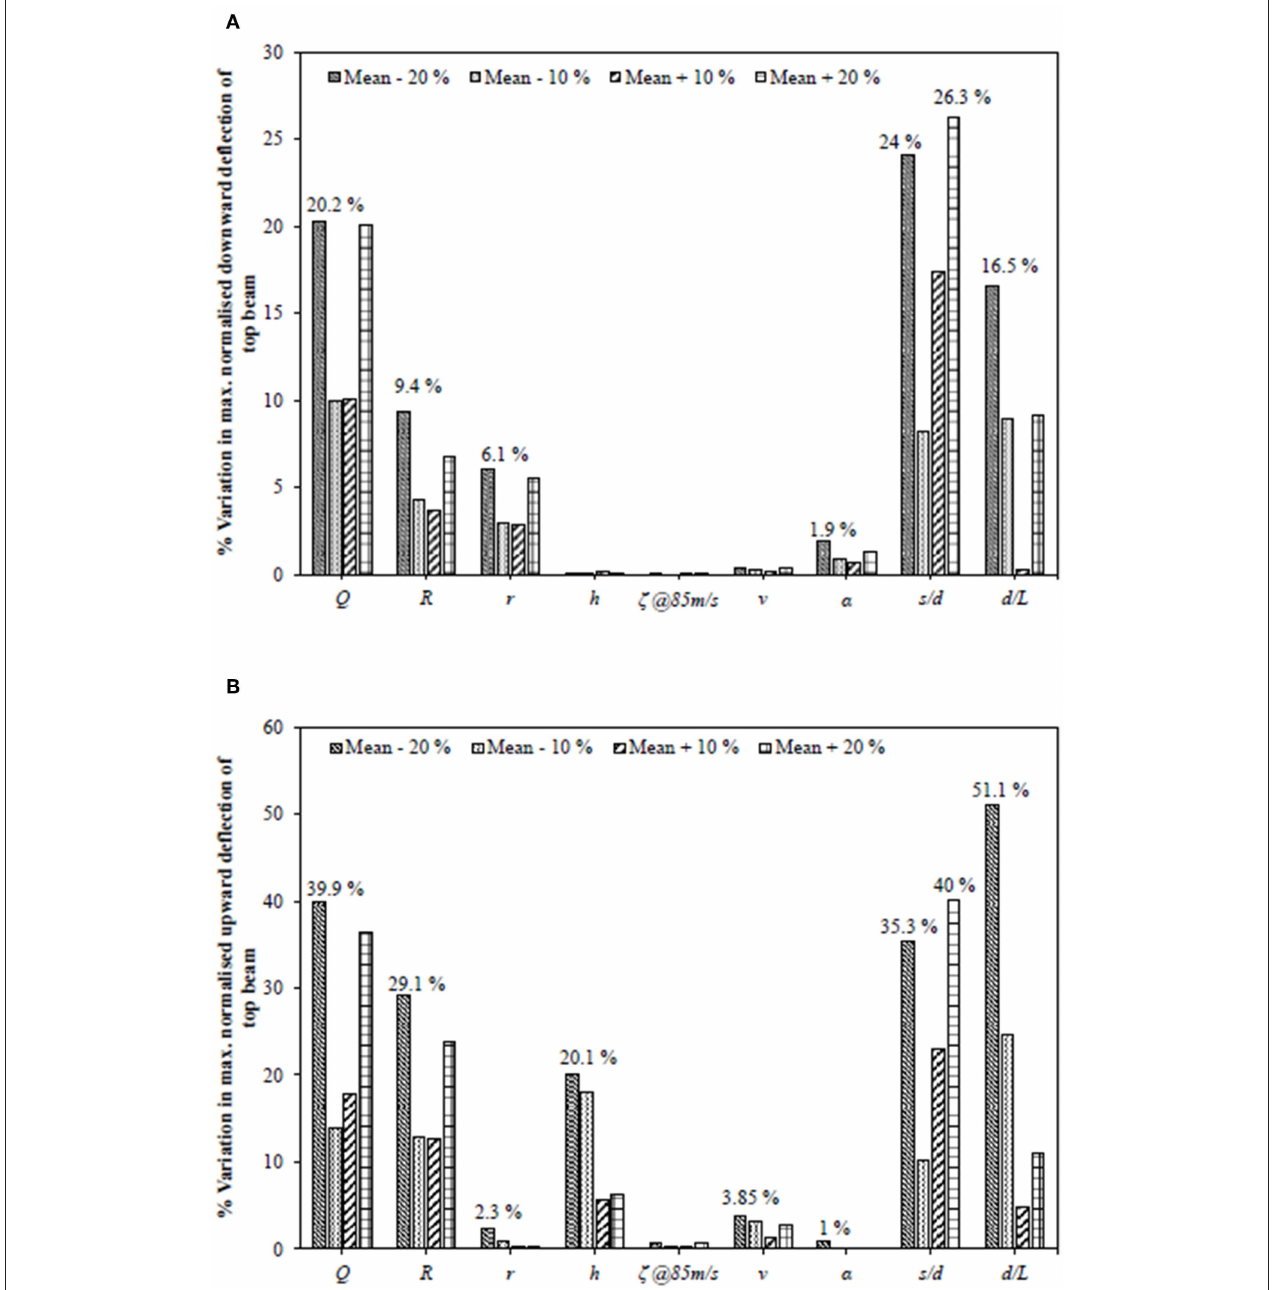
FIGURE 14 | Sensitivity analysis: (A) downward deflection, (B) upward deflection of top